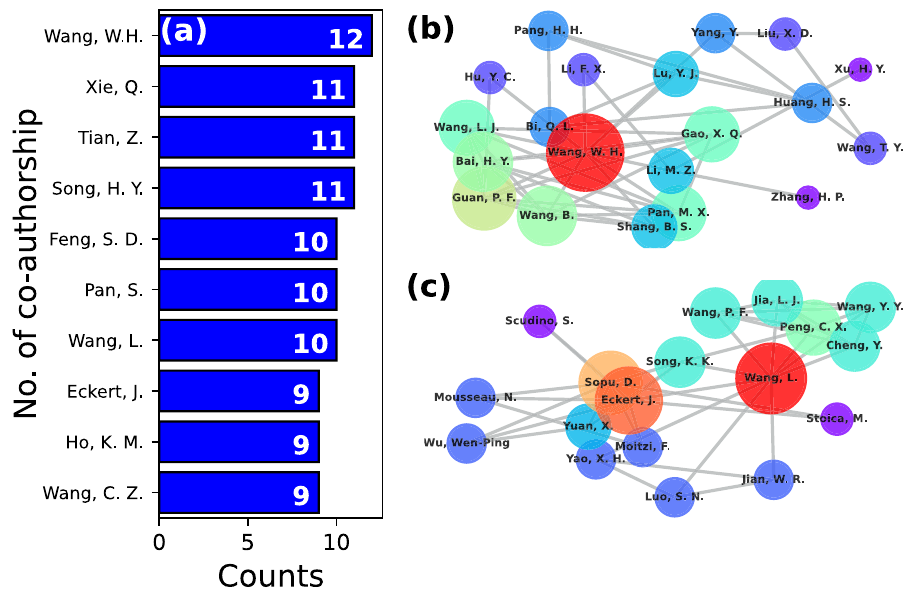
Fig. 7 a Top ten authors with higher number of co-authors in the time period from 2017 to 2021. b , c The two main components of the co-authors network. Large node size and red color correspond to high collaboration, while small size and purple to low collabora-